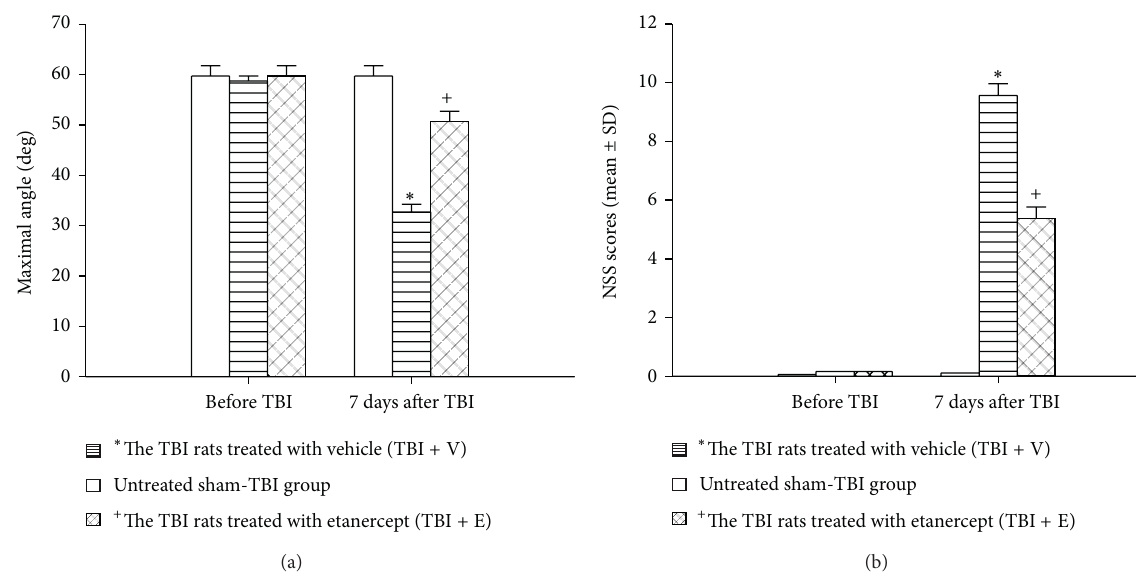
Figure 1: Etanercept attenuated TBI-induced increased neurological NSS and decreased motor performance. ∗ The TBI rats treated with vehicle (TBI + V) (lined column; 𝑛 = 8 ) showed a significant increase in NSS ( 𝑃 < 0.01 ) and a significant decrease in maximal angle ( 𝑃 < 0.05 ) compared with the untreated sham-TBI group (white column) 7 days after TBI. + The TBI rats treated with etanercept (TBI + E) (crossed column; 𝑛 = 8 ) showed a significant decrease in NSS ( 𝑃 < 0.05 ) and a significant increase in maximal angle ( 𝑃 < 0.05 ) compared with the (TBI + V) group (lined column; 𝑛 = 8